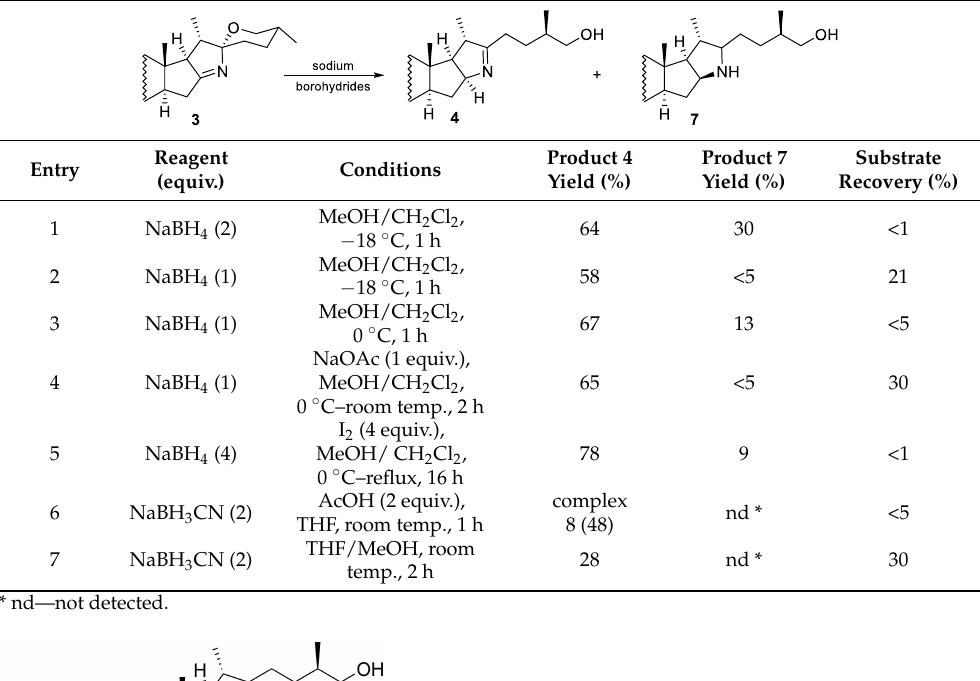
Figure 2. Complex 8 formed during the imine 3 reduction with NaBH 3 CN/AcOH. Table 1. The optimization of imine 3 reduction conditions. Table 1. The optimization of imine 3 reduction conditions.